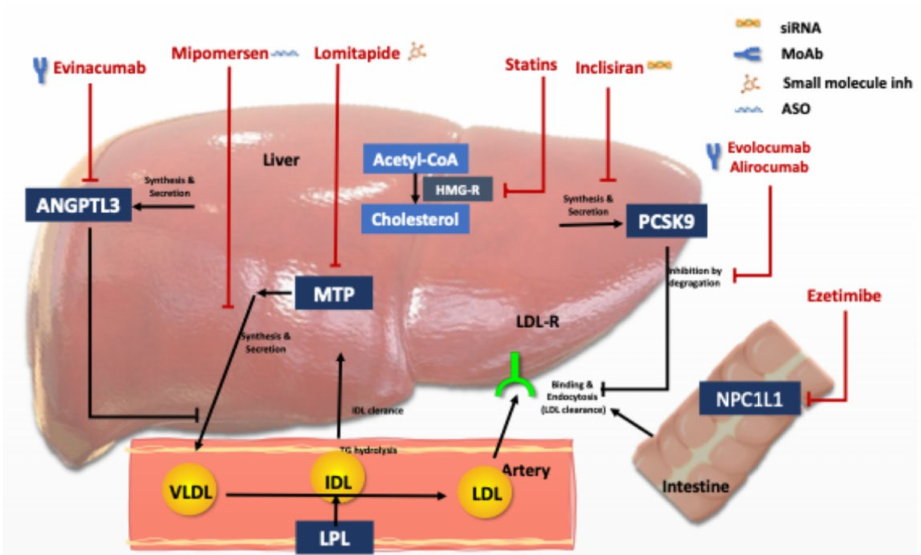
Figure 1. Lipid lowering agents used for Homozygous FH treatment and their mode of